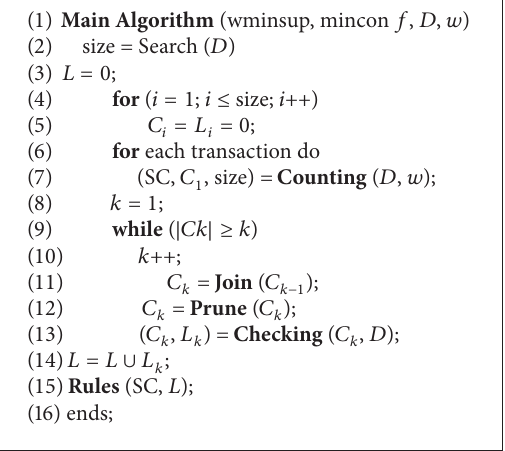
Table 3: Weight of each order.